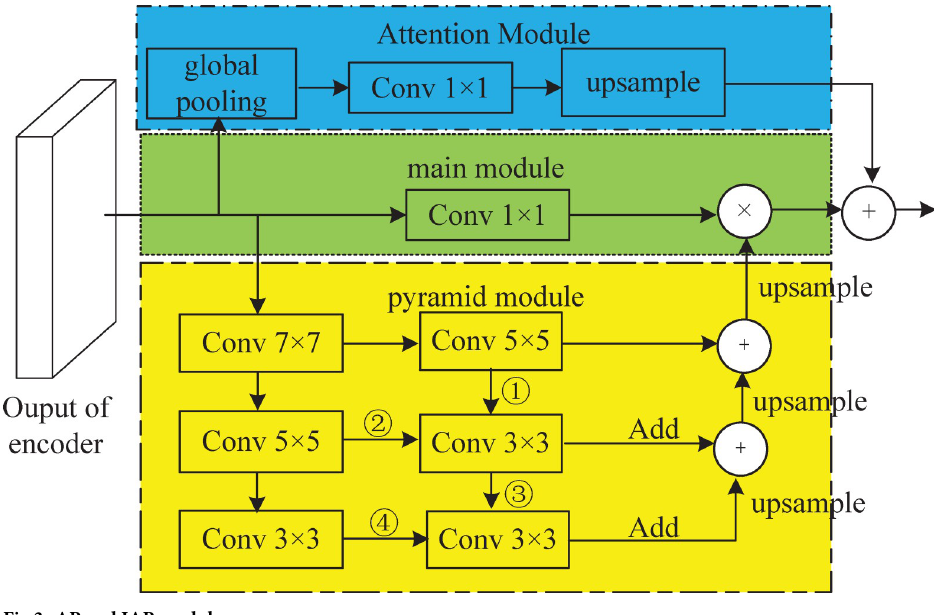
Fig 3. AP and IAP